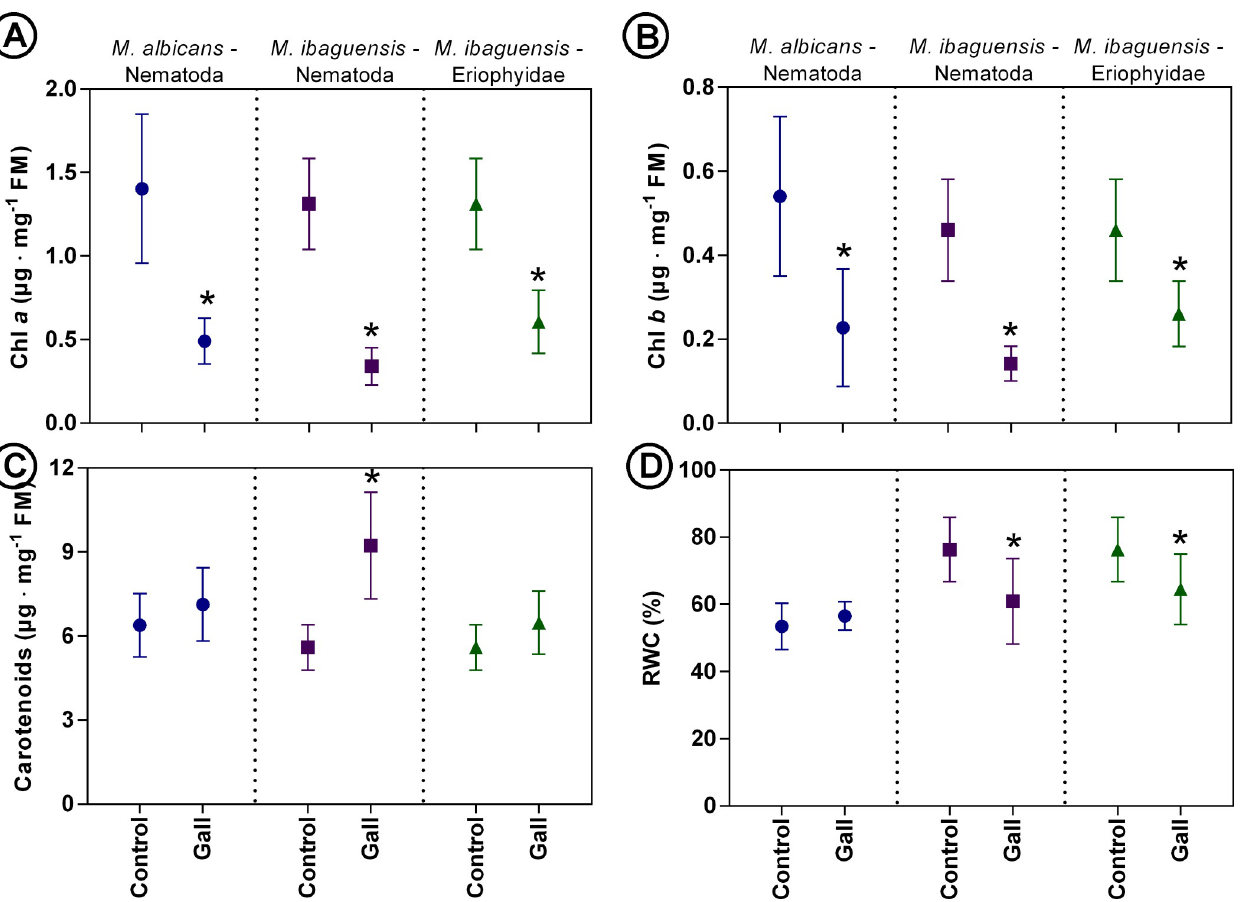
Fig 3. Chloroplast pigments ( μ g g -1 ) and relative water content (%) in leaves and galls induced by Ditylenchus gallaeformans (Nematoda) on Miconia albicans ; by D . gallaeformans on M . ibaguensis ; and by an unidentified Eriophyidae on M . ibaguensis . (A) Chlorophyll a . (B) Chlorophyll b . (C) Carotenoids. (D) Relative water content (RWC). Bars indicate the means and standard deviations. Asterisks indicate significant differences ( P < 0.05).